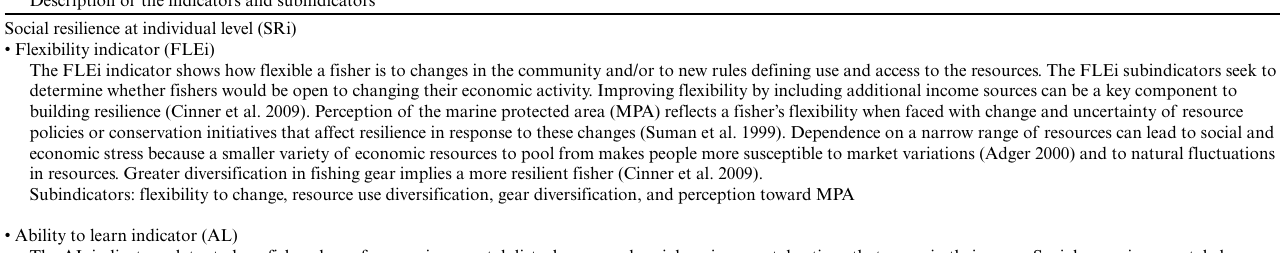
Table 1 . Description of the indicators and subindicators of the three components of the social-ecological resilience index (SERI). Description of the indicators and